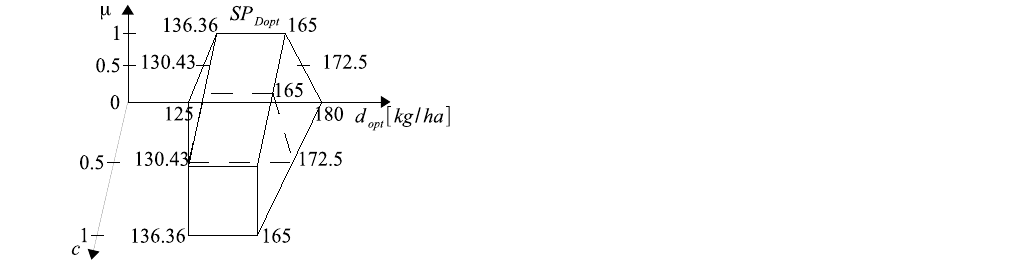
Figure 36. The span SP Dopt ( µ , c ) of the 5D set D opt ( µ , c , γ 1 , γ 2 ) of possible “optimal” doses [ kg/ha ] of nitrogen fertilizer for SB -cultivation.